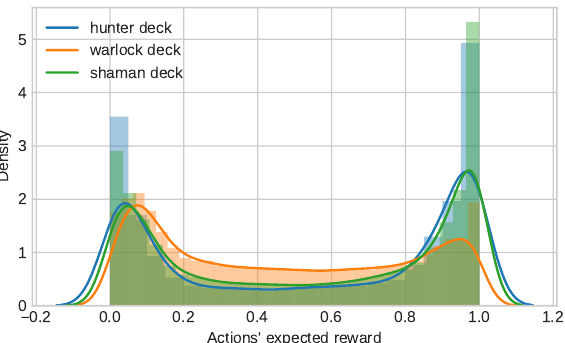
Figure 2. Actions’ expected rewards estimated distributions in